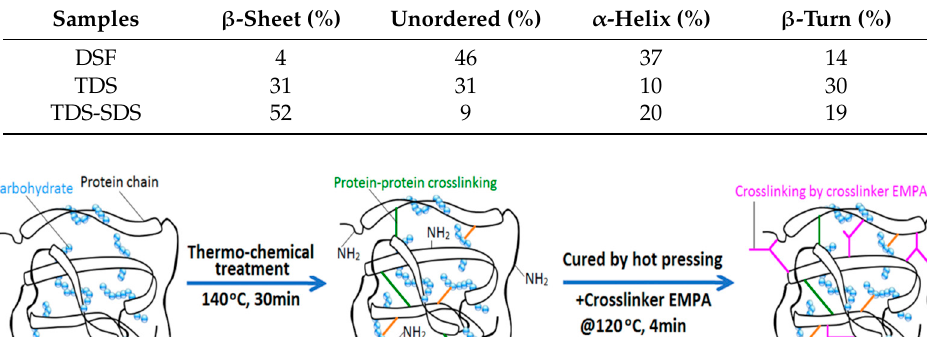
Figure 7. X-ray Diffraction Spectroscopy (XRD) patterns of various DSF samples. Table 2. Secondary structure content in the DSF, TDS, and TDS-SDS samples.